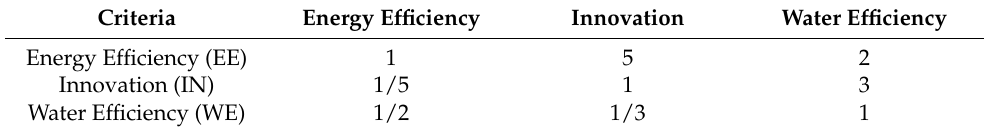
Table 1. Calculation of criteria.